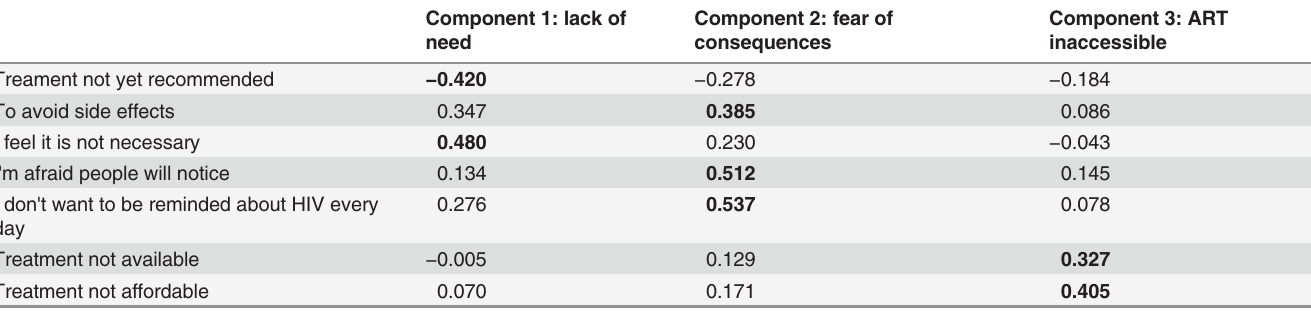
The factor analysis performed with varimax rotation suggested to group together the re- maining seven reasons into three factors showing a low correlation between them. Loadings for each variable were high and did not cross-load between the factors (with the exception of ‘ Side effects ’ which loaded on both component 1 and component 2; see Table 4). We labelled the three components as 1) perceived lack of need (includes “ my doctor says I don't need ART at the moment ” , “ I do feel it is not necessary ” ), mentioned by 3,259 (93.2%) of the eligible respon- dents; 2) fear of consequences (includes “ to avoid the side effects ” , “ I ’ m afraid people will no- tice ” , “ I don ’ t want to be reminded about HIV everyday ” ), mentioned by 428 (12.2%); and 3) ART inaccessible ( “ I can ’ t afford the treatment ” , “ The treatment is not available in the country I live in ” ), mentioned by 86 (2.5%) of the respondents. The (relatively strong) loading of the reason “ To avoid the side effects ” on component 1 (lack of need) may reflect the decision to stop treatment because of side effects being taken in conjunction with medical advice. It could also reflect a joint decision of physician and patient to postpone starting ART to avoid side effects. Table 5 shows numbers and proportions of men identifying the respective answers, grouped by categories and sub-regions. The rank order of answers was very similar in all sub-regions with minor variations between the western sub-regions. For all reasons retained in further anal- ysis (except “ treatment not being recommended ” ), an East-West gradient was evident (see Table 5). Men living in the WHO Central and Eastern European Regions were more likely than men living in the combined western sub-regions to feel that treatment was not yet necessary, to be afraid of side effects, to be unwilling to be reminded about HIV every day, or to be afraid of people noticing they have HIV. They were also more likely to state that they could not afford treatment, or that the treatment was not available in the country where they lived. Fear of side effects was very similar in the EMIS Central-West and WHO Central European region, and the reason “ I don ’ t want to be reminded about HIV everyday ” was as frequent in EMIS Northwest and EMIS Central-West as in the WHO Central European region. Table 4. Rotated component matrix of reasons for never taking or stopping ART. Component 1: lack of Component 2: fear of need